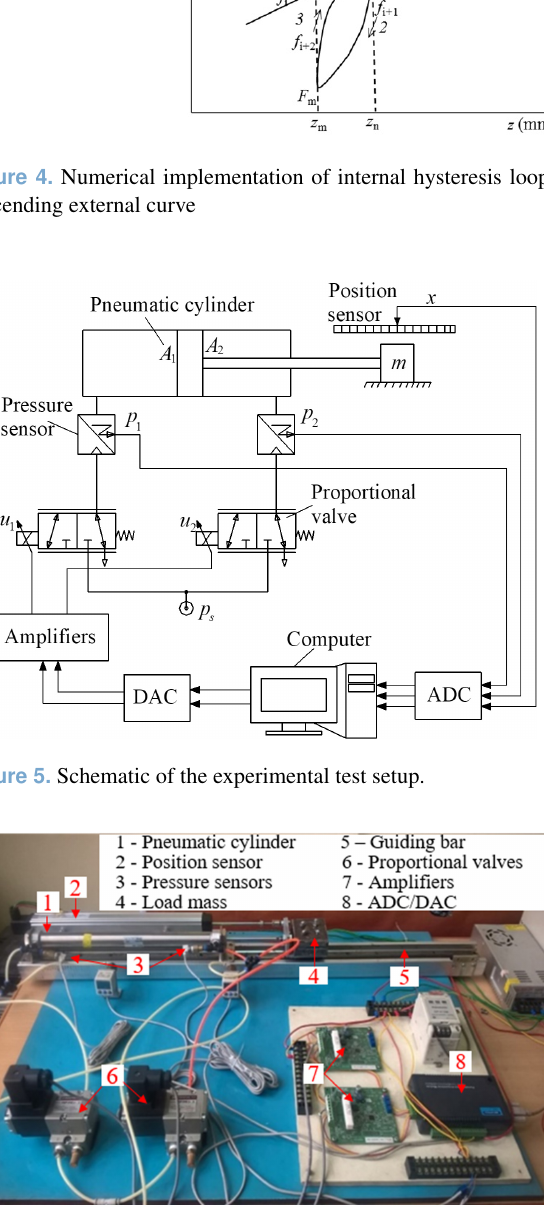
Figure 6. Photo of the experimental test setup.